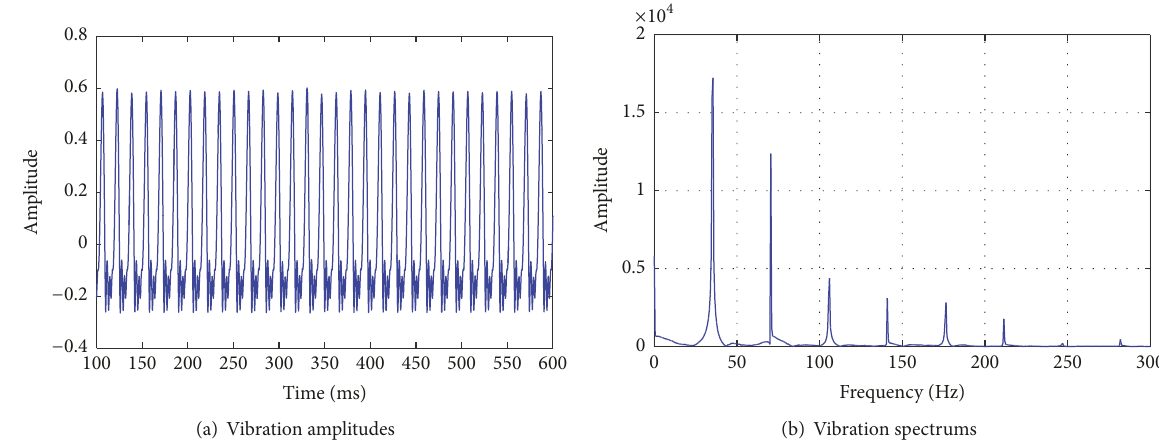
Figure 9: The horizontal direction response of the position of pedestal looseness ( 𝜆 = 0.1 , 𝛿 = 0.00002